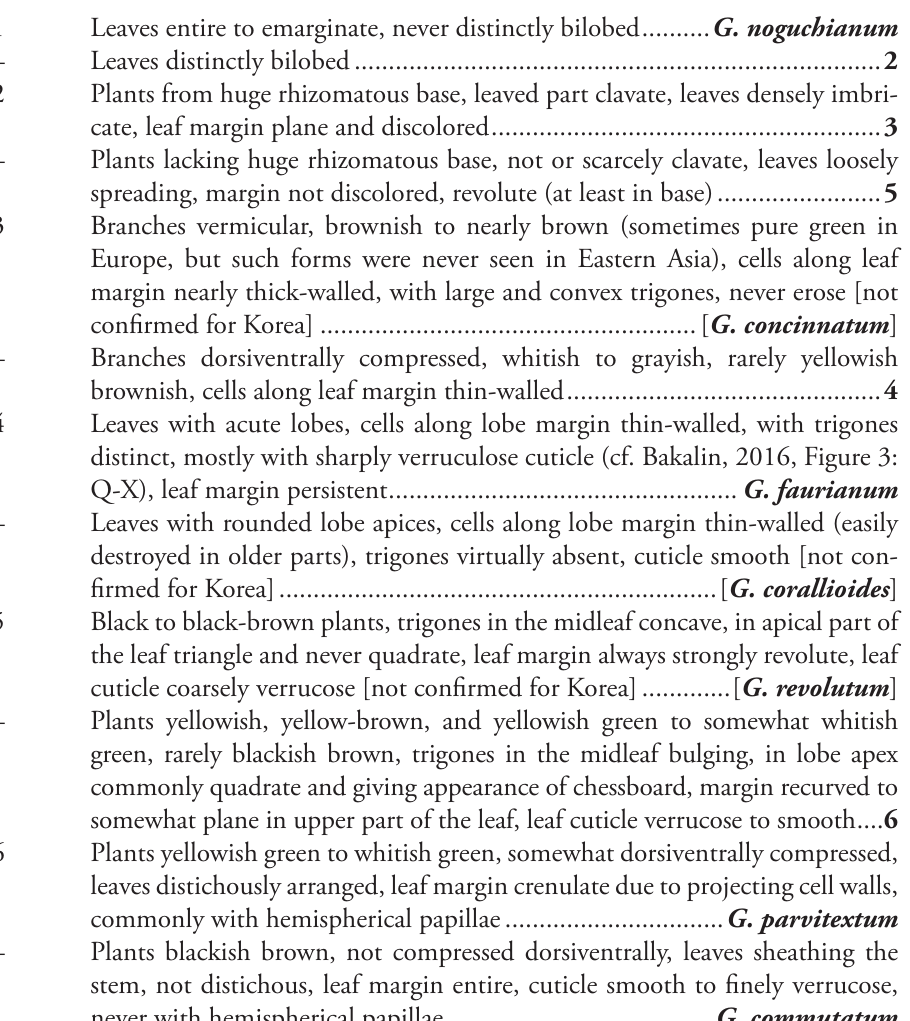
Gymnomitrion commutatum (Limpr.) Schiffn., Magyar Bot. Lapok 13: 304,